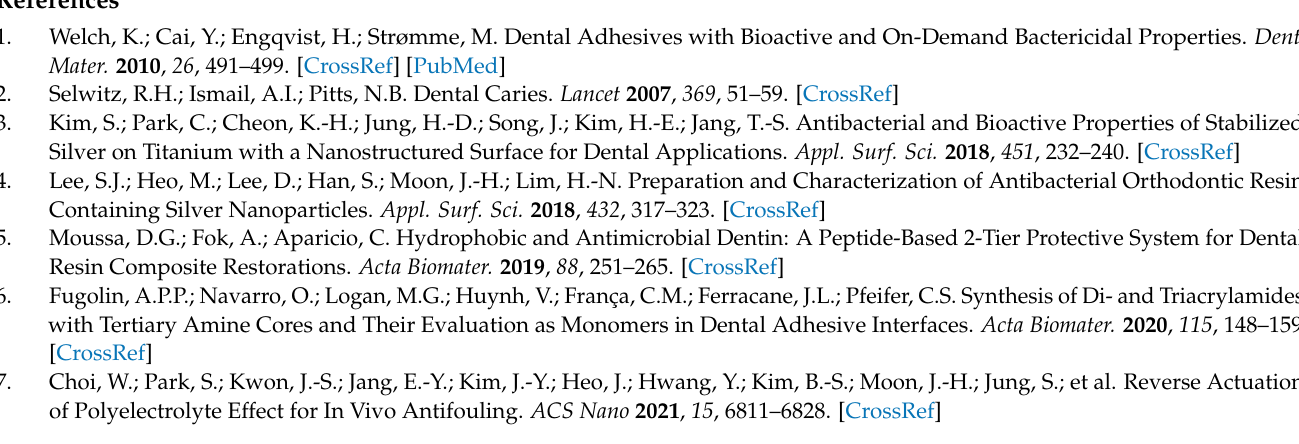
Table S1: The mean diameters of the inhibition halos of the pure Bi QDs with different